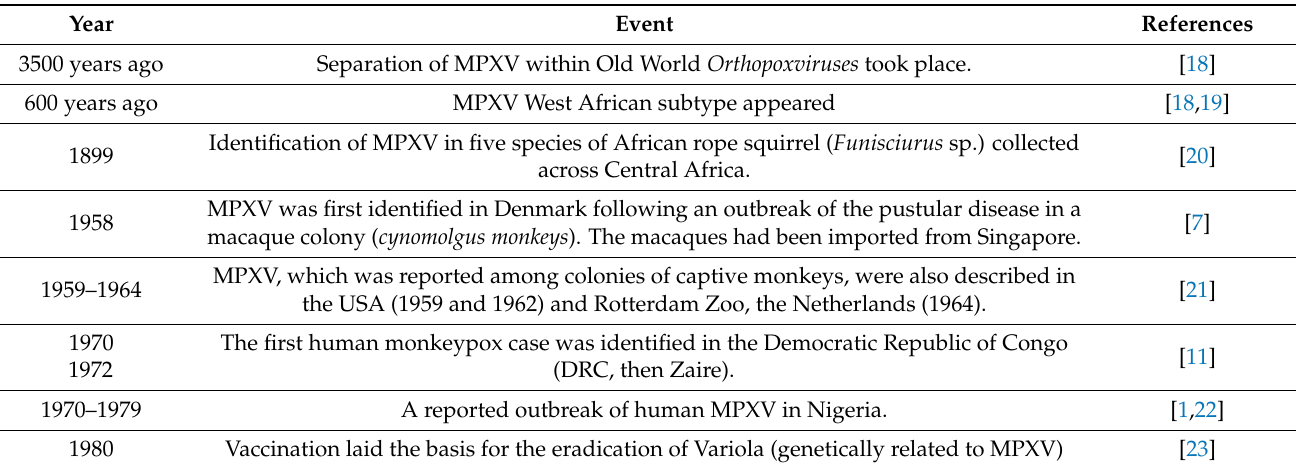
Table 1. Timeline of Monkeypox virus-related